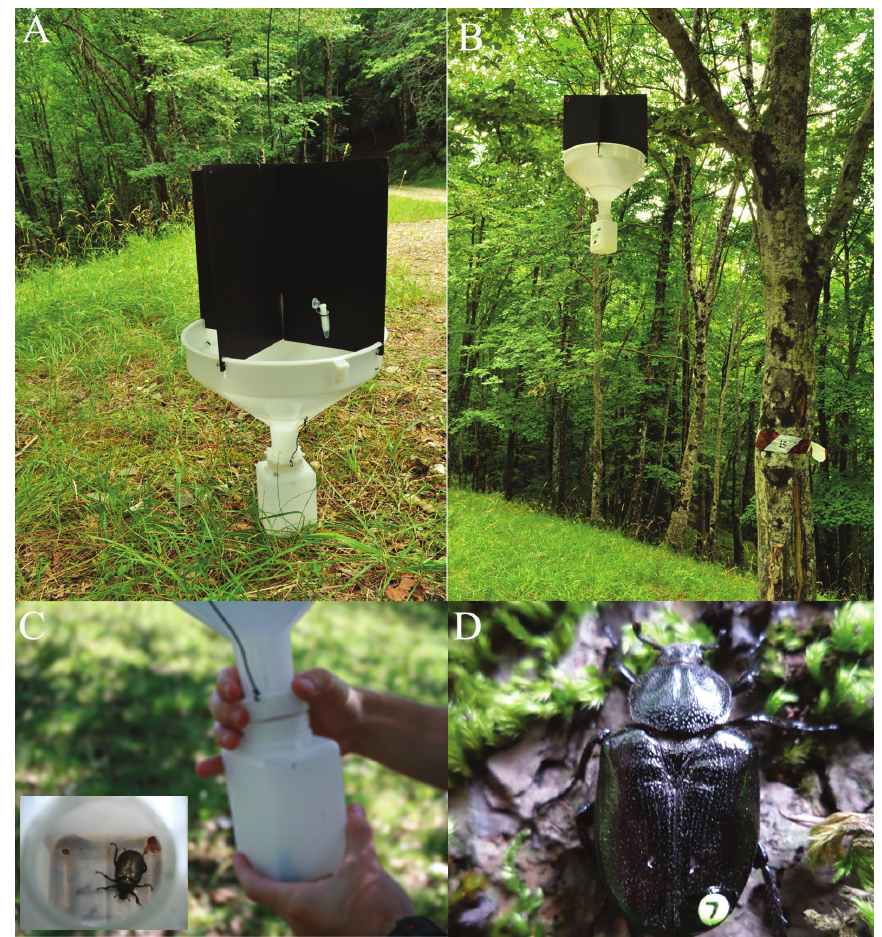
Figure 7. BCWT for capturing O. eremita . A Outline of a trap with an eppendorf vial containing the pheromone B positioning on tree branch C insertion of the funnel into the bottle, with details of hermit beetle captured by the trap (note the four small holes in the base to avoid water filling) D O. eremita with double marking procedure on elytra: dimples made by a small drill and a numbered sticker (photographs by E. Capogna: A–B , F. Bernardini: C , S. Chiari: D